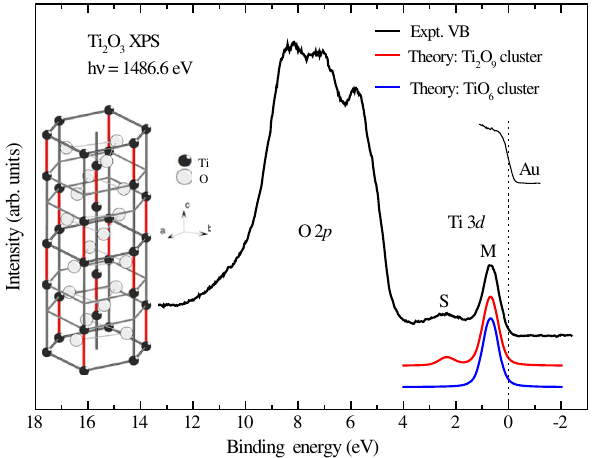
FIG. 1. Experimental valence-band (VB) XPS spectrum of Ti 2 O 3 taken at 300 K (black line), together with the Au Fermi cutoff (thin black line) as reference for E 3 d one-electron removal spectrum from the TiO the Ti 2 O 9 (red line) clusters, as described in the text. Inset: Corundum structure of Ti 2 O 3 , with the c -axis Ti-Ti dimers marked in